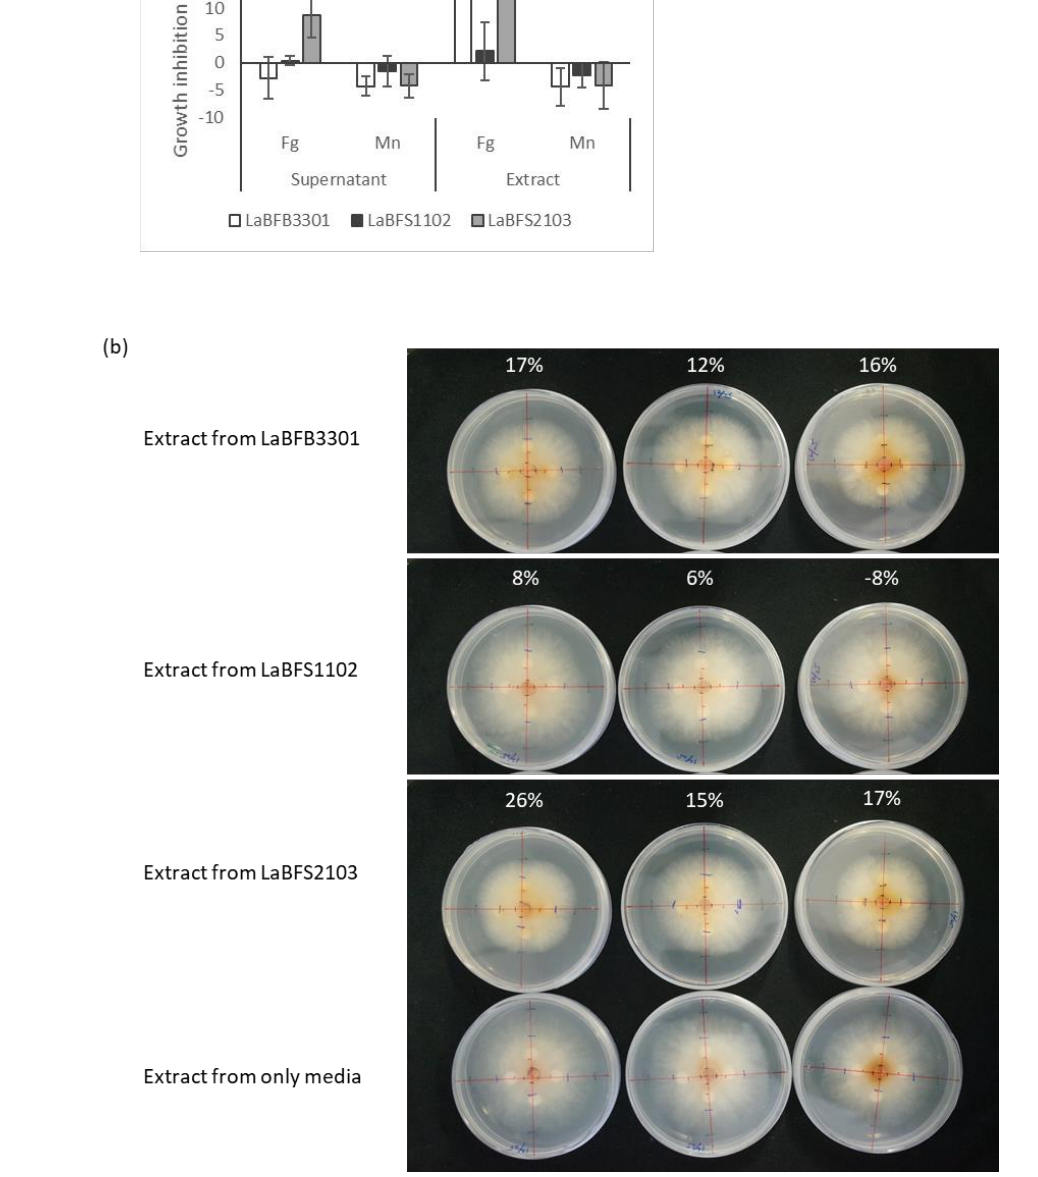
Figure 10. Growth inhibition test of cell-free supernatant and methanolic extracts of three endo- phytic bacteria, LaBFB3301, LaBFS1102 and LaBFS2103 against mycelial growth of F. graminearum (Fg) and M. nivale (Mn) after 3-day culture. ( a ) Mean growth inhibition rate with SE as error bars; ( b ) cultured plates of F. graminearum on day 3. The above number represents the growth inhibition rate.